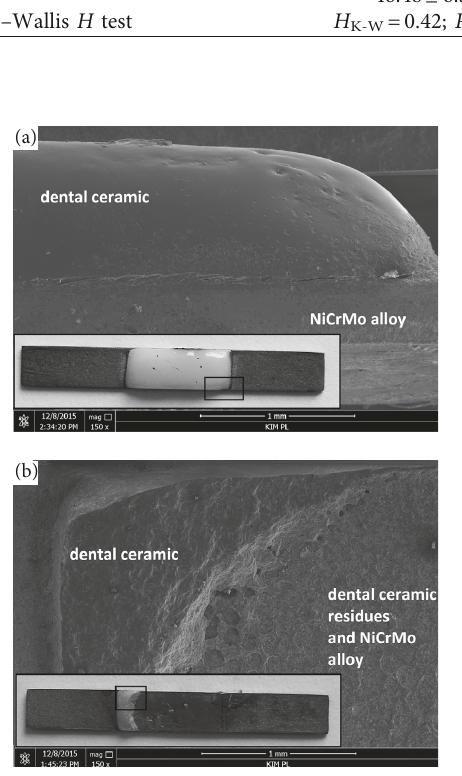
Figure 5: SEM images of the specimens after the three-point bending test: (a) specimen 100; (b) specimen 0.